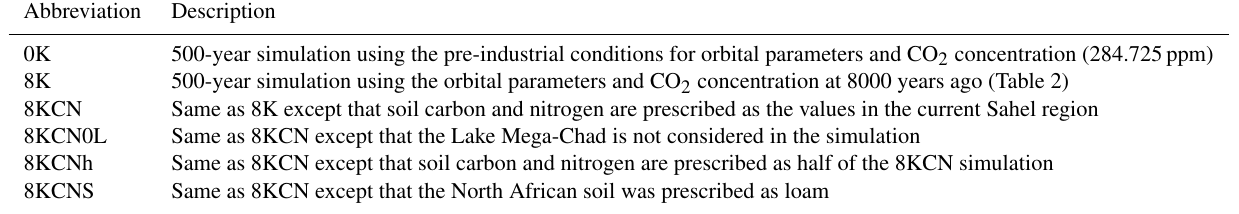
Table 1. The abbreviations of the numerical experiments conducted in this study.